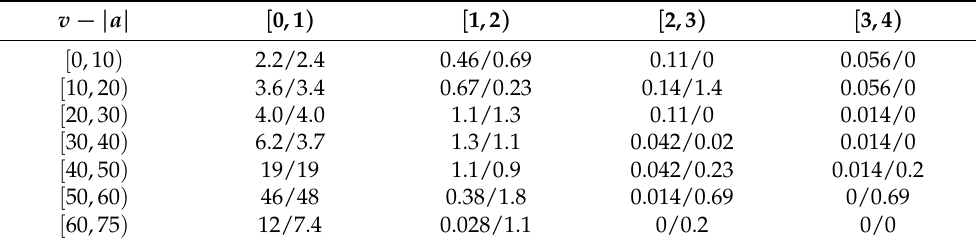
Table 5. Velocity-acceleration ( v − | a | ) probability distribution matrix of the original data/cycle(%). v − | a